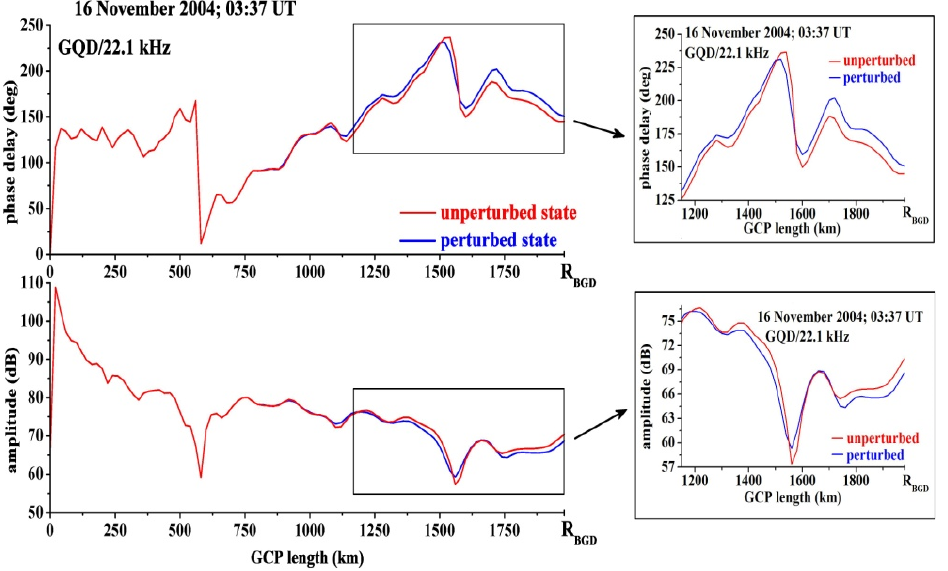
Figure 7. Simulated amplitude and phase delay along GCP path towards the Belgrade receiver, for unperturbed (red) and perturbed (blue) ionospheric states for GQD/22.1 kHz VLF signal waveguides, on 16 November 2004.